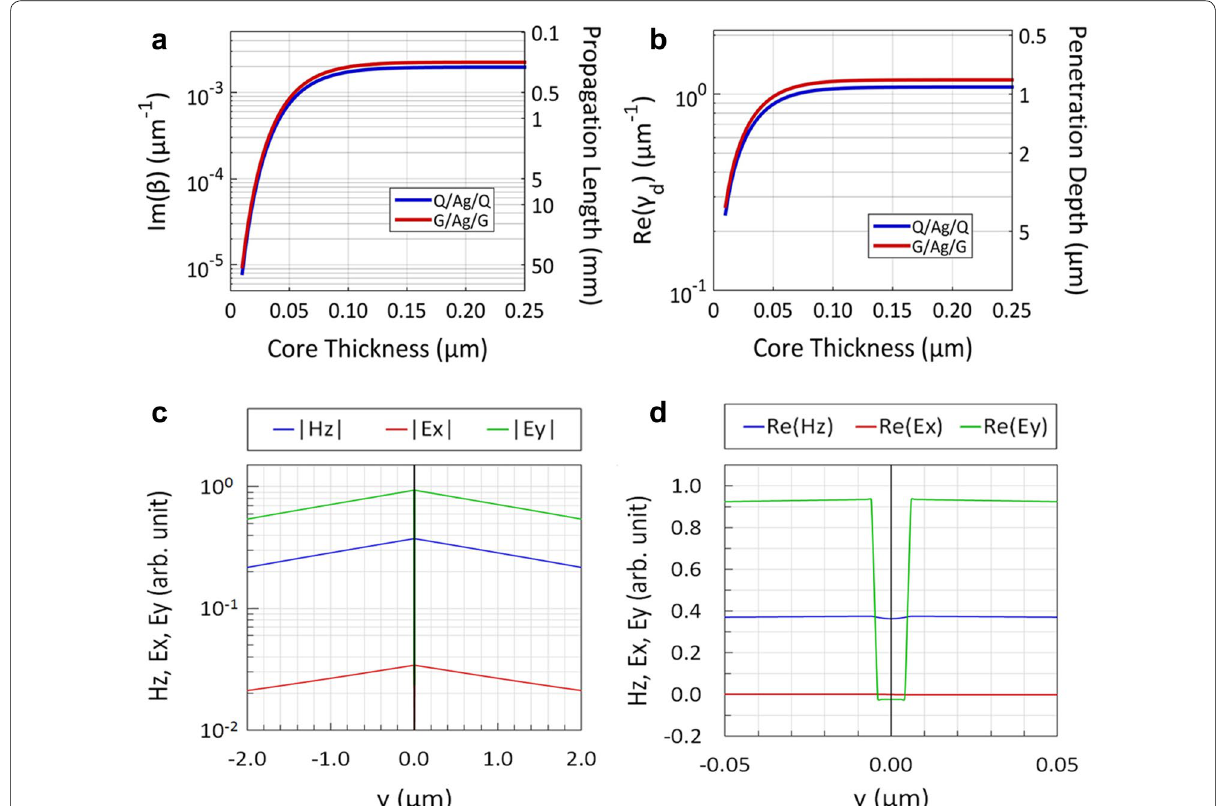
Fig. 9 Analysis of a thin-metal-core waveguide structure with symmetric dielectric cladding: silica (Q) or soda-lime glass (G). a Analytical calculation of propagation length for metal core (Ag) thickness in the range of 10–250 nm. b Analytical calculation of penetration depth into cladding. c FDTD simulation of field distributions in SiO 2 /10-nm Ag/SiO 2 structure: log-scale plot of field amplitudes of H z , E x and E y for y in the range of A close-up view of field distributions around the 10-nm Ag